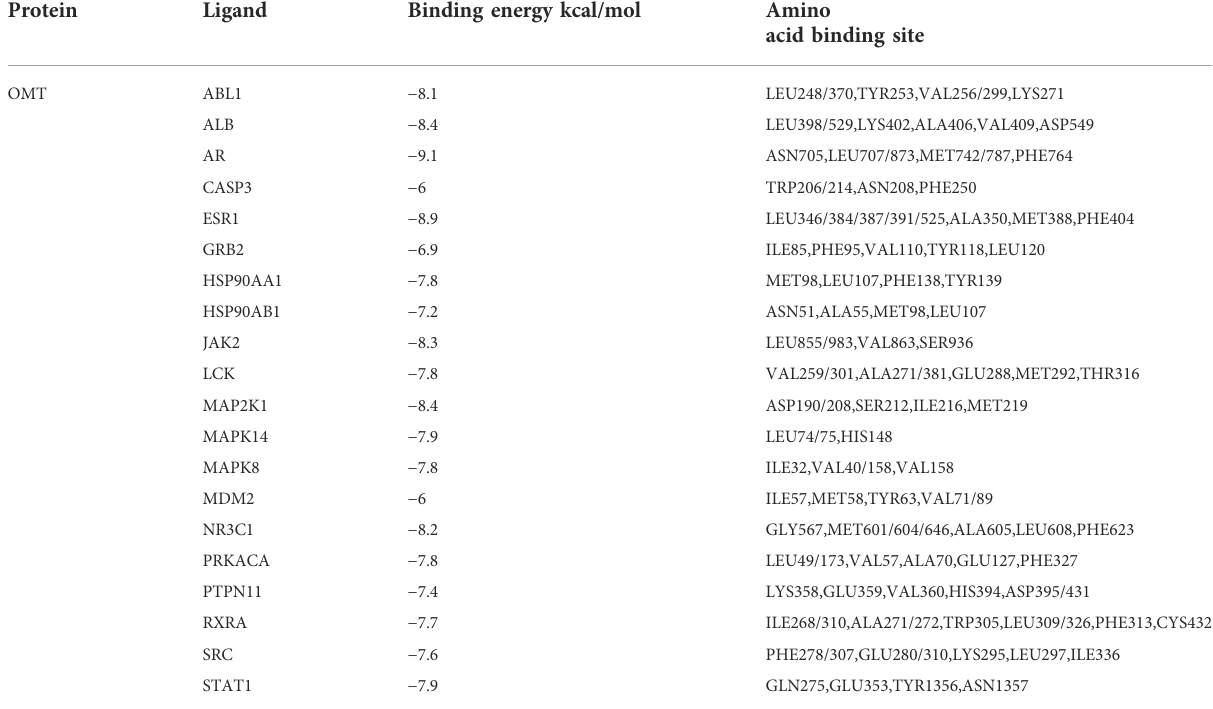
TABLE 3 Af fi nities and amino acid sites of ligand-protein detected by molecular docking. Protein Ligand Binding energy